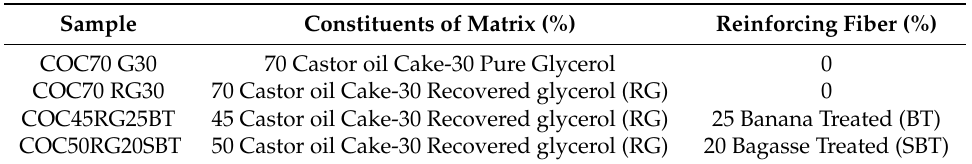
Table 1. Details of composite samples